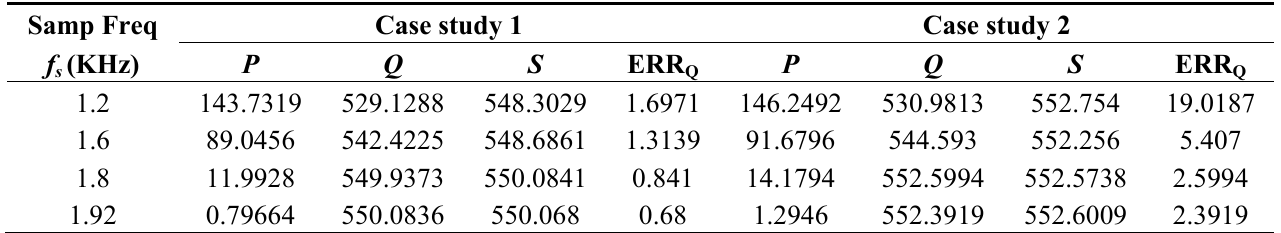
Table 6. Effect of sampling frequency on power measurement. Samp Freq Case study 1 Case study